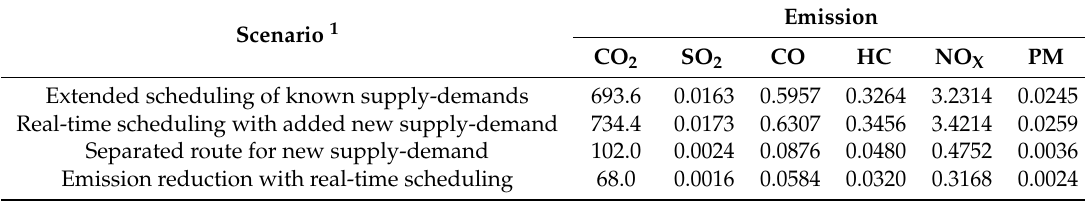
Table 13. Calculated GHG emission in the case of photovoltaic-based electricity generation.